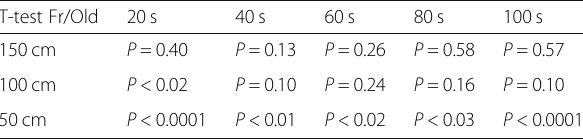
Table 1 Difference between fresh and old feet. At 150 cms perfusion pressure the fresh feet showed no difference in IOP between 60 to 100 s (32.4 mmHg to 29.8 mmHg, p =